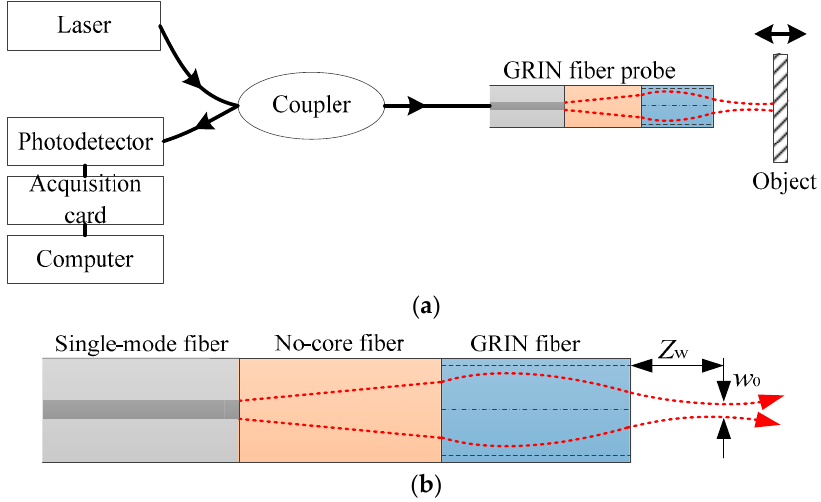
Figure 1. The schematic diagram of the Fabry–Perot (F–P) fiber interferometer based on the ultra-small gradient-index (GRIN) fiber probe: ( a ) the schematic diagram of the interferometer system; ( b ) the schematic diagram of the ultra-small GRIN fiber probe in the interferometer system.